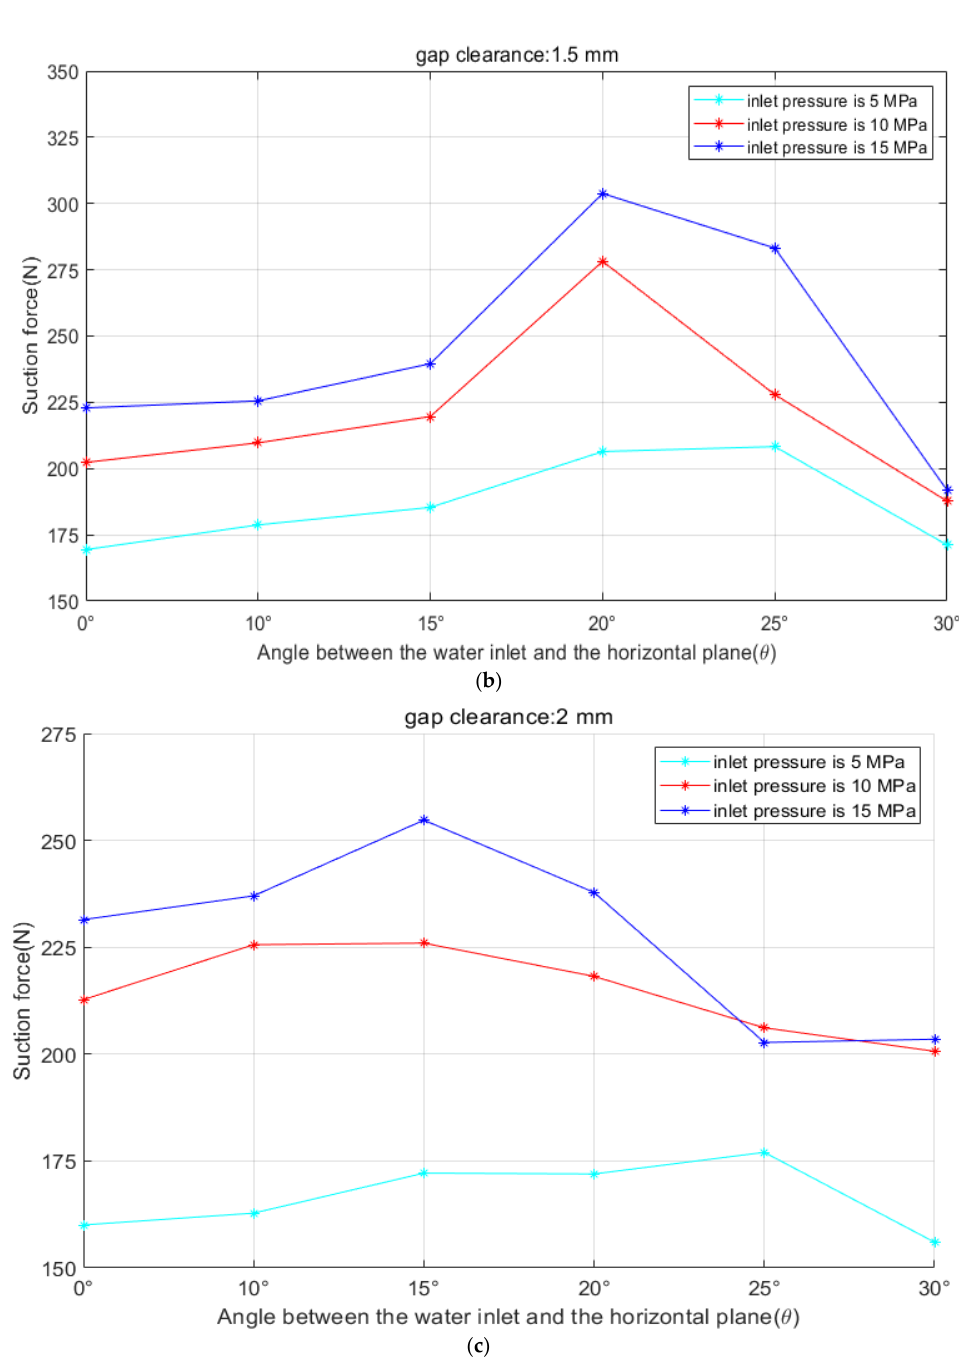
Figure 12. Test results of suction force for six vortex suction cups ( θ = 0 ◦ ,10 ◦ ,15 ◦ ,20 ◦ ,25 ◦ ,30 ◦ ) at varied inlet pressures (from 5 to 15 MPa: ( a ) gap clearance=1 mm; ( b ) gap clearance=1.5 mm; ( c ) gap clearance=2 mm.